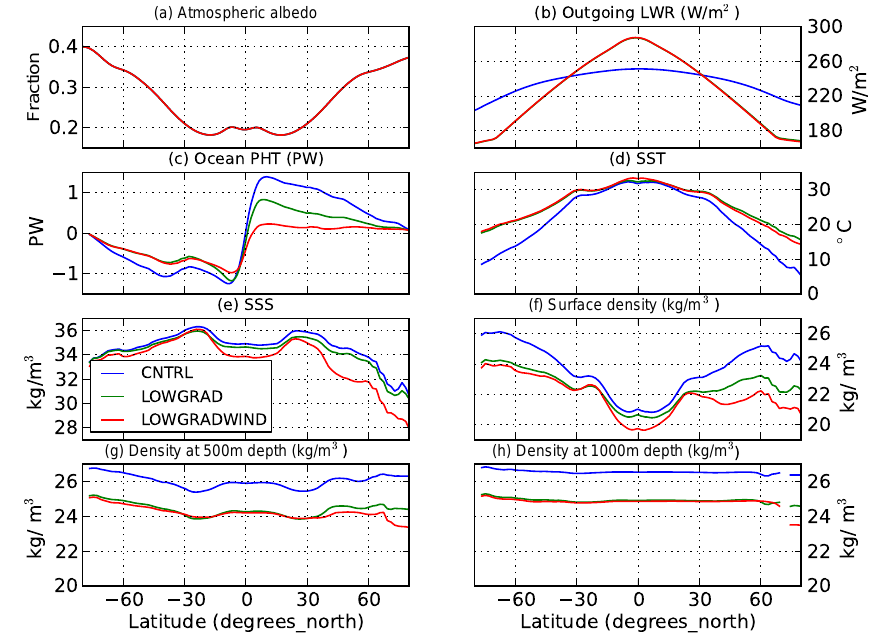
Figure 4. Global zonal mean of (a) atmospheric albedo (fraction) (b) outgoing longwave radiation (Wm − 2 ), (c) oceanic poleward heat transport (petawatts), (d) sea surface temperature (SST, ◦ C), (e) sea surface salinity (SSS, kgm − 3 ) and (f) ocean potential density (kgm − 3 ) for the control case CNTRL (blue), the low temperature gradient case LOWGRAD (green), and the low temperature and weak wind case LOWGRADWIND (red). Bottom row as (f) at depths (g) 500m and (h)